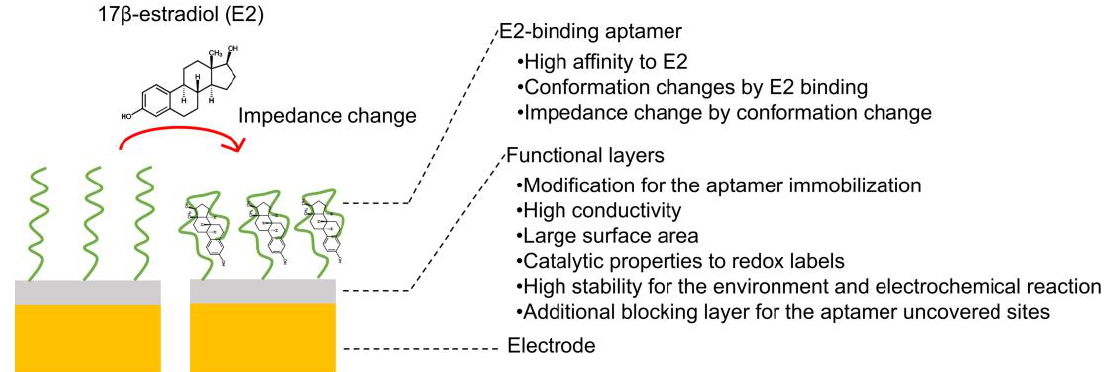
Figure 4. Simplified structure of estradiol aptasensors based on impedance change.